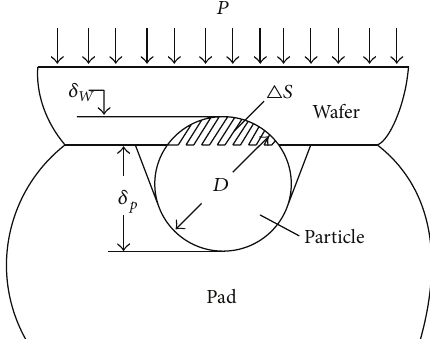
Figure 1: Schematic of pad/wafer/particle three-body contact.